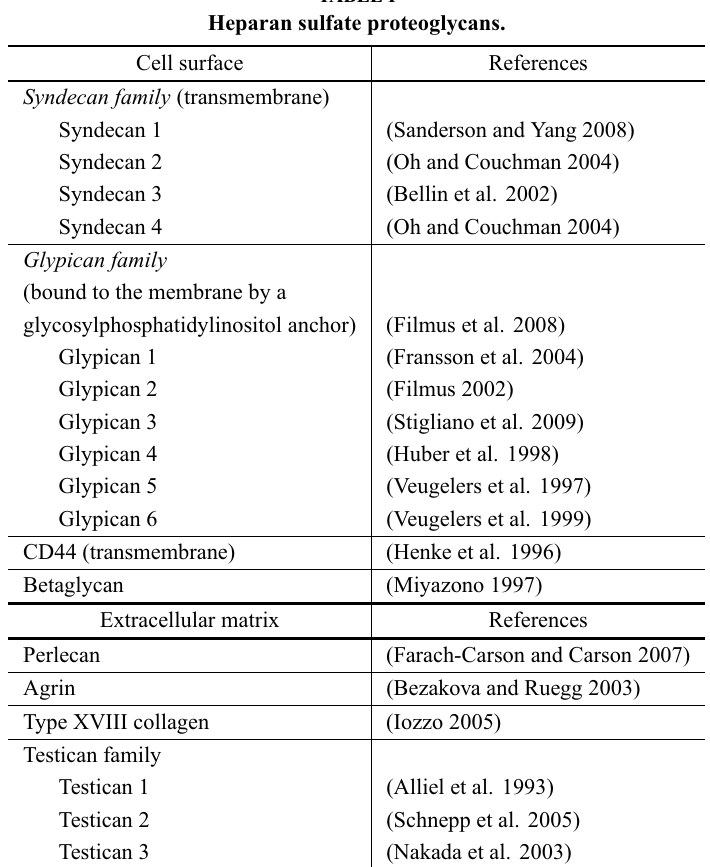
Heparan sulfate